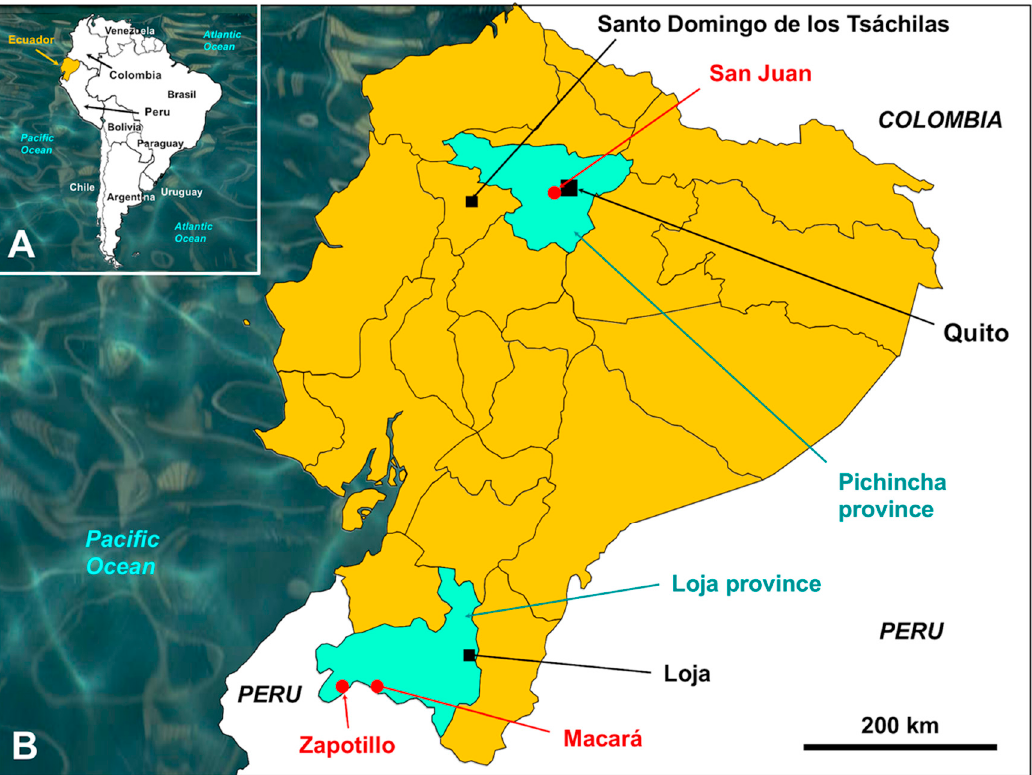
Figure 1. Maps showing the localities surveyed: ( A ) map of South America showing the location of Ecuador neighboring northern Peru and southern Colombia; ( B ) map showing the Pichincha province including the San Juan endemic area providing liver fluke infected sheep and cattle and Santo Domingo de los Tsachilas along the route from Quito to the Pacific coast, and the southern zone of Loja province showing the localities where cattle was surveyed in Zapotillo and Macará close to the country border with Peru.